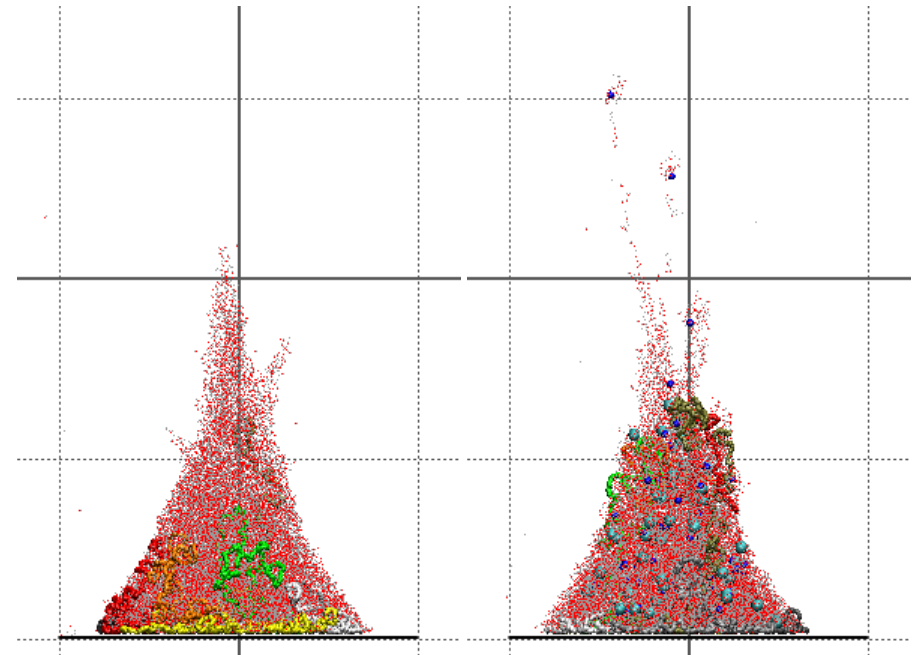
Figure 9. Snapshots from a production trajectory at 42 ps of the systems with eight 10.55-kDa chains without ions ( left ) and with 72 NaCl ion pairs ( right ) under 1.5 V/nm. In the right panel, the sodium ions (blue spheres) escaping the droplet are visible. As a visual aid, a 10-by-10-nm grid is displayed. For color scheme see Figure 3. Graphics made with Visual Molecular Dynamics